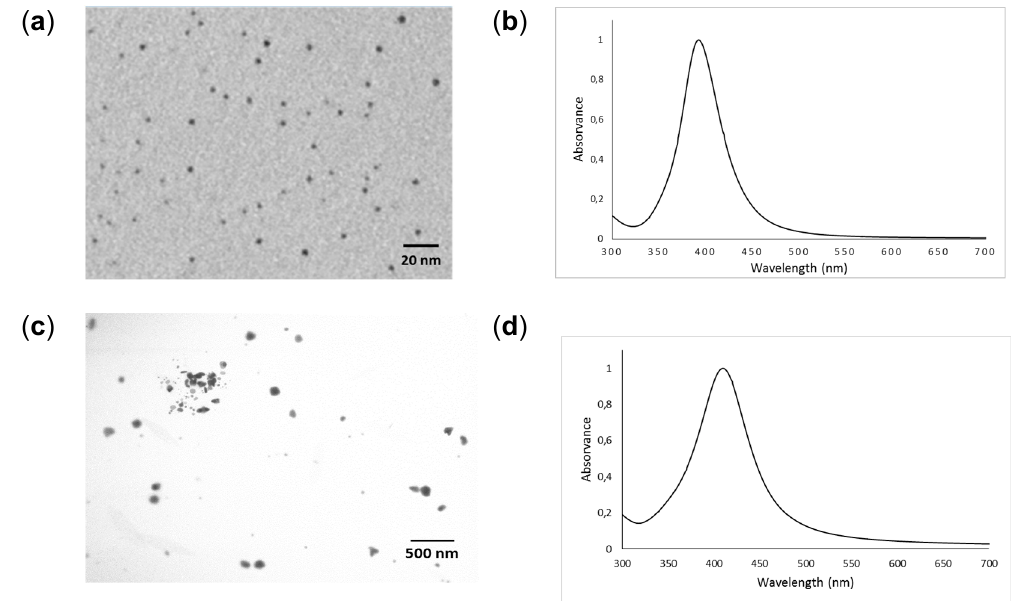
Figure 1. Characterization of silver and silver coated with polyvinylpyrrolidone nanoparticles. ( a ) TEM image for the synthesized Ag colloid ( b ) UV-visible absorption spectra ( c ) TEM image for the synthesized PVP-Ag colloid ( d ) UV-visible absorption spectra.